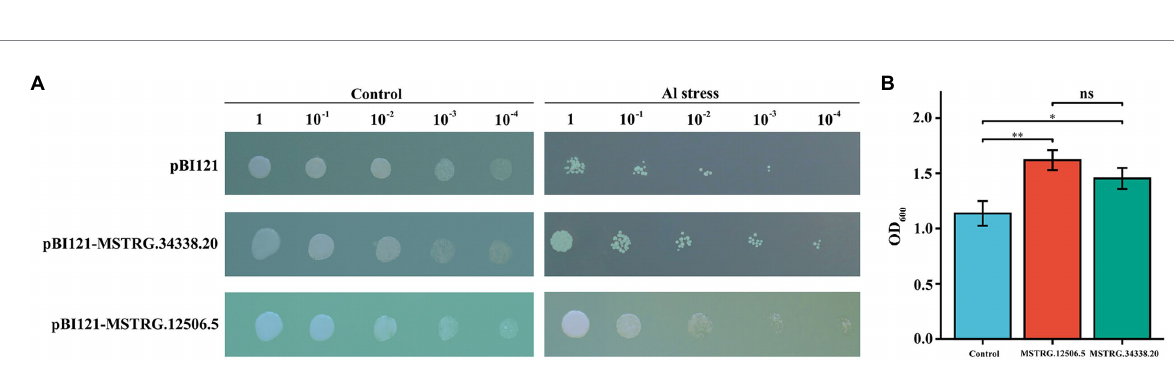
FIGURE 6 Phenotypic growth assay and concentration assay of transgenic INVSc1 cells under Al stress. (A) Aliquots of serially diluted (1, 10 − 1 , 10 − 2 , 10 − 3 , and 10 − 4 ) cultures on 10 μ M Al SC-Ura media with the yeast containing a pBI121 empty vector, pBI121-MSTRG.12506.5, or pBI121-MSTRG.34338.20. (B) Yeast growth in SCu/2% (w/v) glucose liquid media supplemented with 10 μ M